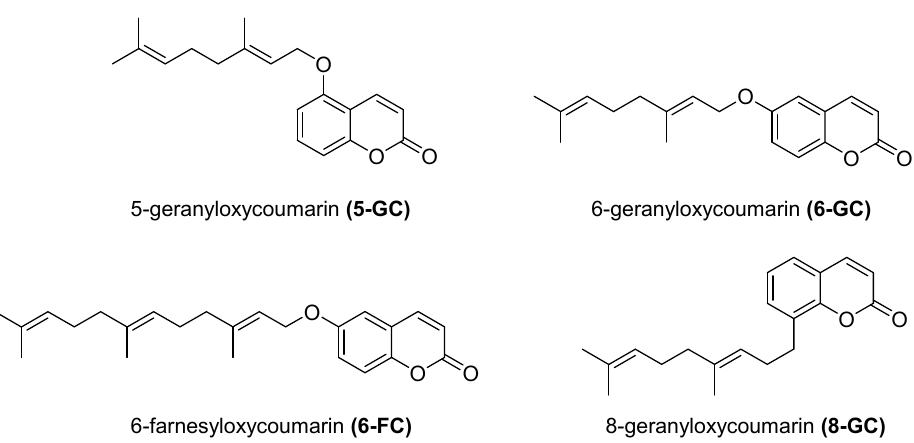
Figure 7. Structure of the most active O -prenylated coumarins.